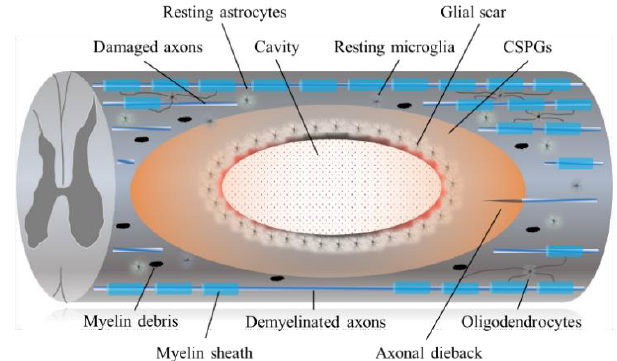
Figure 1. The diagram shows the pathophysiological events in the chronic SCI. Injury to the SCI results in death of neuronal as well as glial cells. Progressive demyelination results in degeneration of axonal fibers that leads to disruption of axo-glial signaling. A cavitation has occurred in the epicenter. Hypertrophic astrocytes with very long processes over the tips of non-regenerating fibers form a barrier known as a glial barrier or a glial wall around the cavitation. In response to damage/injury, microglial cells transform into active phagocytic microglia and exhibit chemotaxis (migrates and accumulates at the site of injury). The presence of CSPGs creates an inhibitory environment for axonal regeneration, which leads to failure of axonal growth cones at the injured site of CNS. In addition, CSPG also inhibits the migration and differentiation of oligodendrocyte progenitor cells.